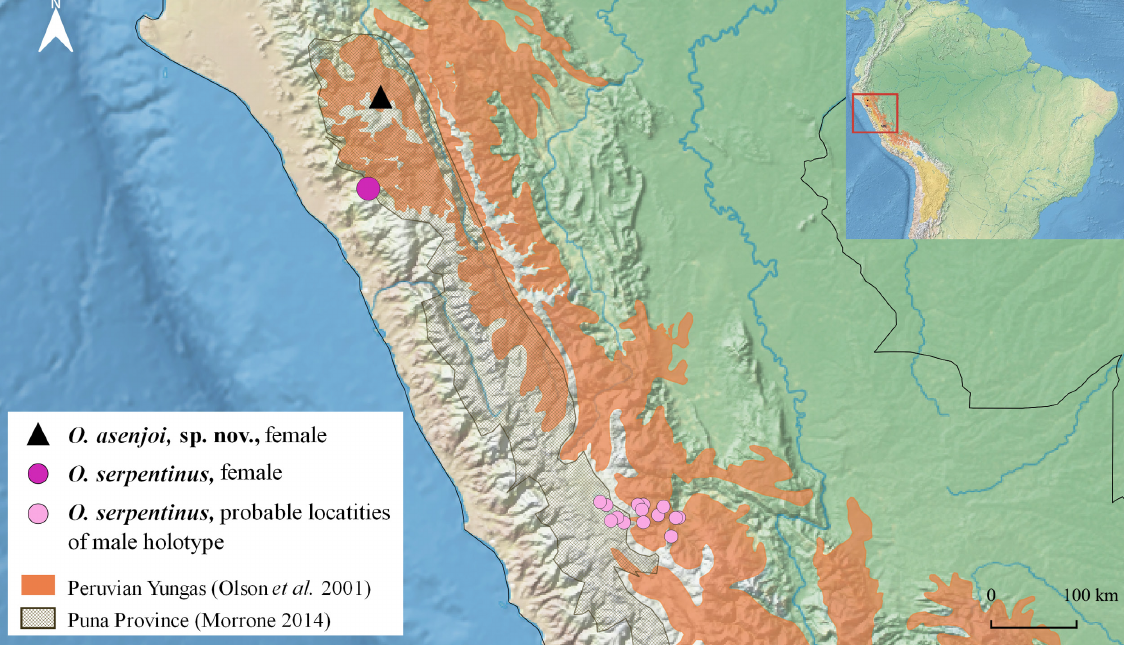
Fig. 4. Distribution map of Ophionthus serpentinus Bernhauer, 1908 and O. asenjoi sp.